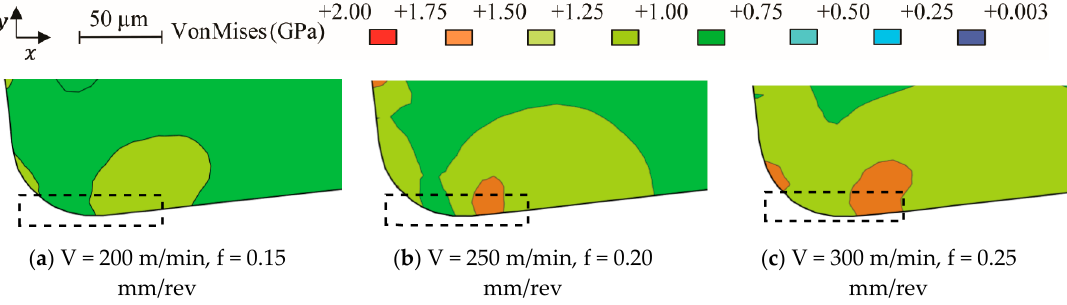
Figure 11. Contour of Von Mises stresses developed in the tool cutting edge when machining at different cutting conditions.